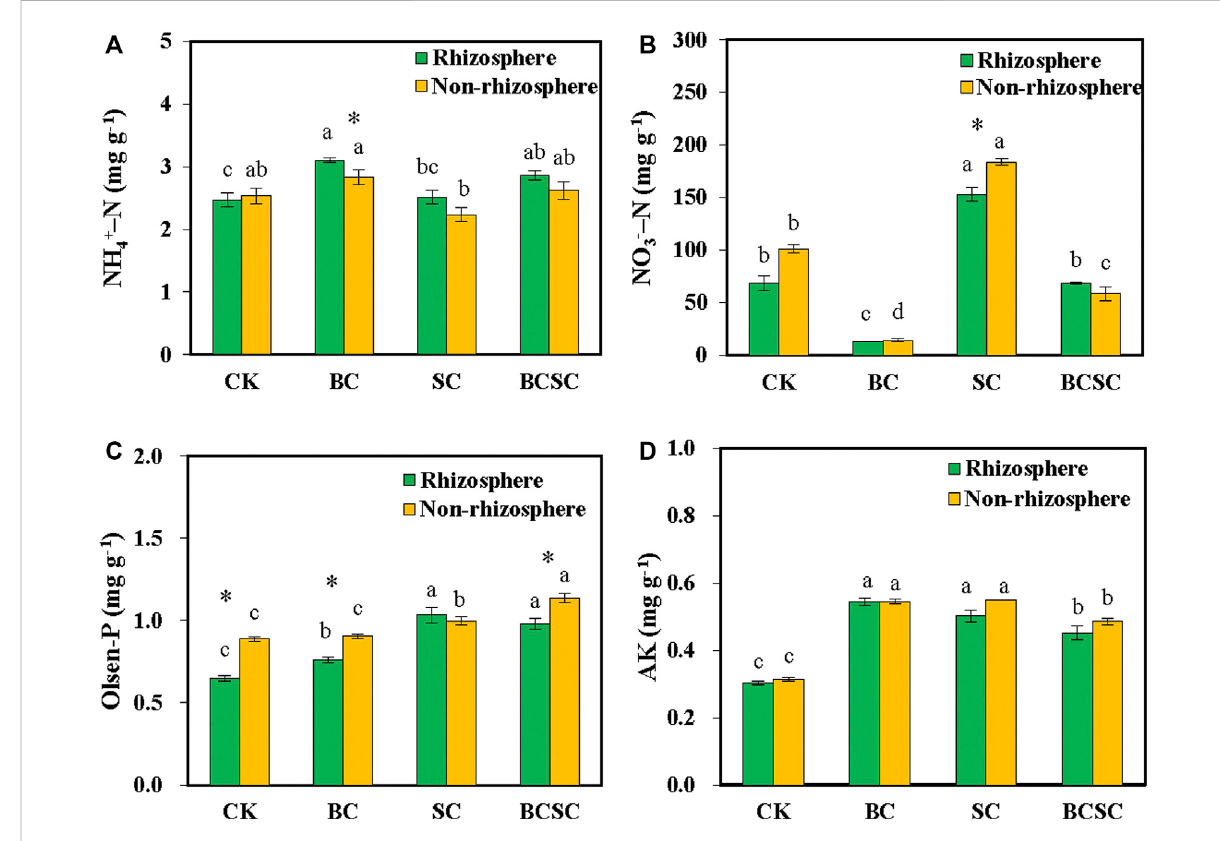
FIGURE 4 Effect of biochar, compost, and biochar-compost addition on N, P and K availability in the soil with sorghum. (A) NH4+ – N, (B) NO3- – N, (C) Olsen-P,and (D) AK.CK:soilwithoutamendment;BC:soilamendedwithcornstrawbiocharat1.0%(w/w);SC:soilamendedwithseaweedcompost at 1.0% (w/w); and BCSC: soil amended with cocomposted biochar and seaweed at 1.0% (w/w). The error bars represent the standard error of the mean ( n = 3). Different small letters indicate the signi fi cant difference between the soil treatments, and asterisks indicate the signi fi